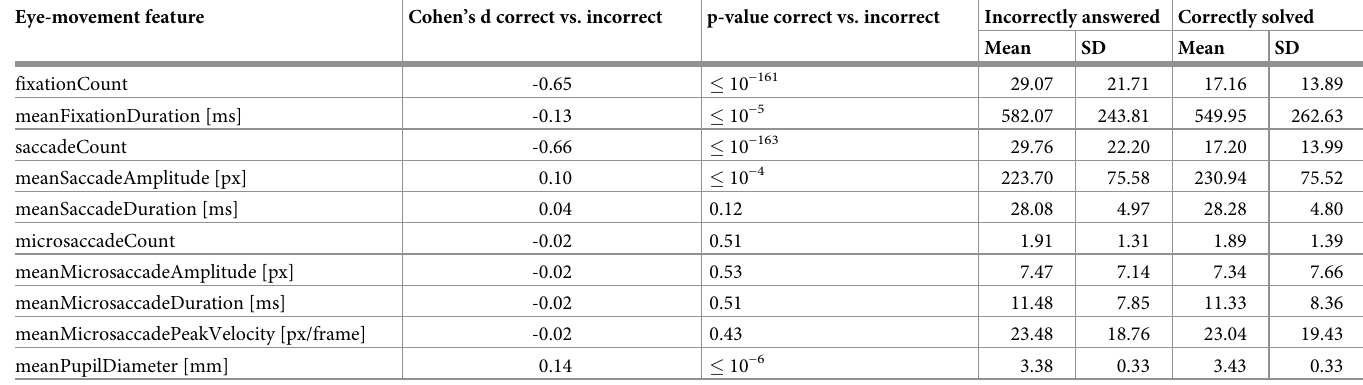
Table 2. Statistical comparison of the eye-movement features during items that were solved correctly vs. those that were answered incorrectly. Eye-movement feature Cohen’s d correct vs. incorrect p-value correct vs.